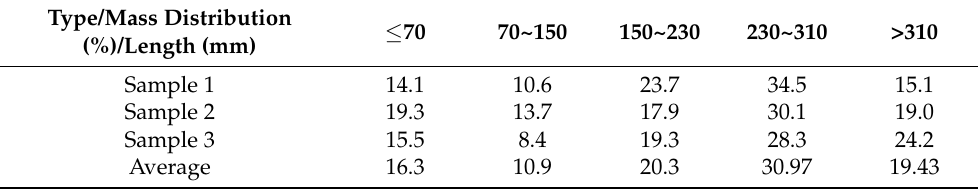
Table 1. Distribution of straw mass in different length intervals.